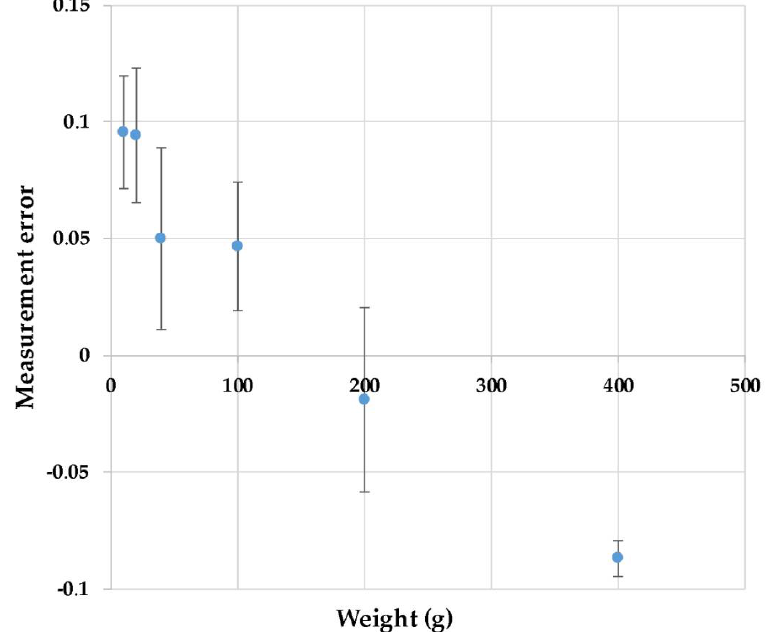
Figure 6. The change in the measurement error between the surface skin temperature and temperature sensing yarn when different weights were attached to the temperature sensing yarn, varying the contact pressure between the yarn and the hand.